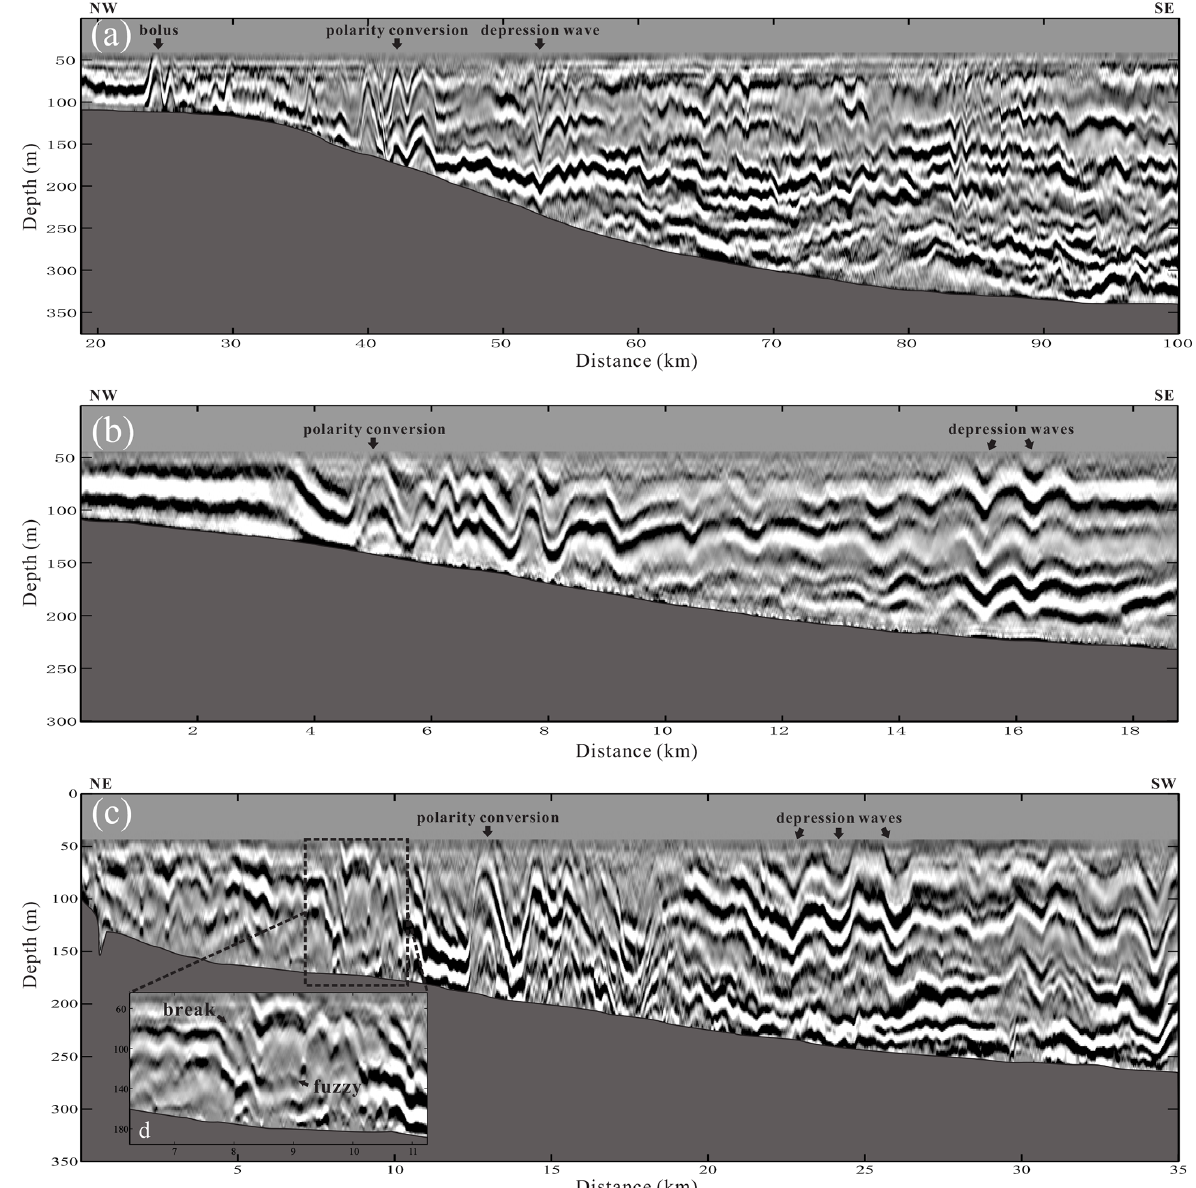
Figure 5. The seismic sections of survey lines L1 (a) , L2 (b) and L3 (c) . The gray regions in the sections represent the seafloor. Internal solitary waves can be seen in all three cases. Panel (d) is the enlarged regional image of